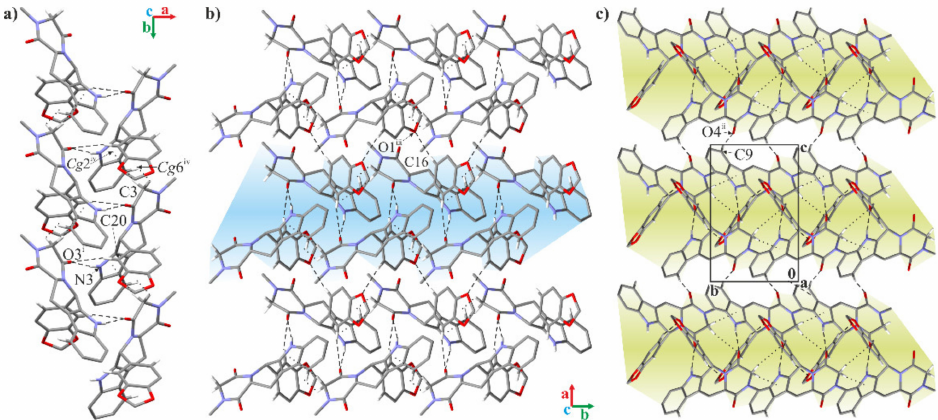
Figure 10. Arrangement of molecules of 1 in the crystal, where: ( a ) chain of molecules running along [010] direction; ( b ) single layer of molecules spreading along (001) plane (single chain of molecules is highlighted in blue); ( c ) general view on layered supramolecular architecture of compound viewed along a -direction (single layers are highlighted in light green). The H-atoms not involved in intermolecular interactions have been omitted for clarity. The N–H · · · O and C–H · · · O hydrogen bonds are represented by dashed lines, while the C–H · · · π contacts by dotted lines. Symmetry codes: (i) − x + 1/2, − y + 1, z − 1/2; (ii) − x + 1, y − 1/2, − z + 1/2; (iii) − x + 3/2, − y + 1, z +1/2; (iv) − x , y + 1/2, − z +